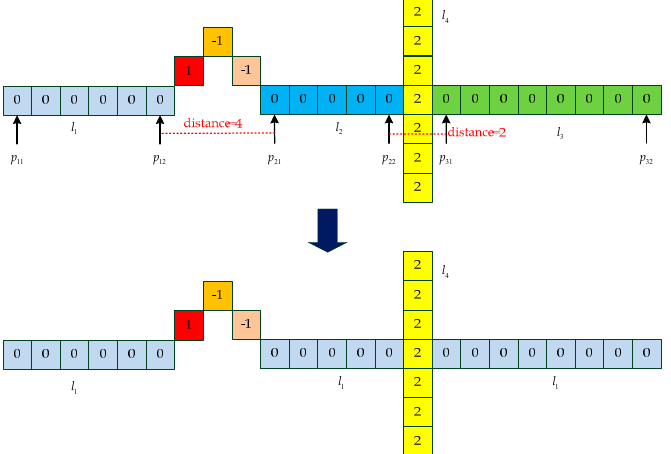
Figure 16. An example for updating lines. We set the distance threshold to 5. For the line l 1 and the line l 2 , the distance between the endpoint p 12 and the endpoint p 21 is less than the threshold. Therefore, the two lines are classified as the same line. In the same way, the line l 2 and the line l 3 are classified as the same line.